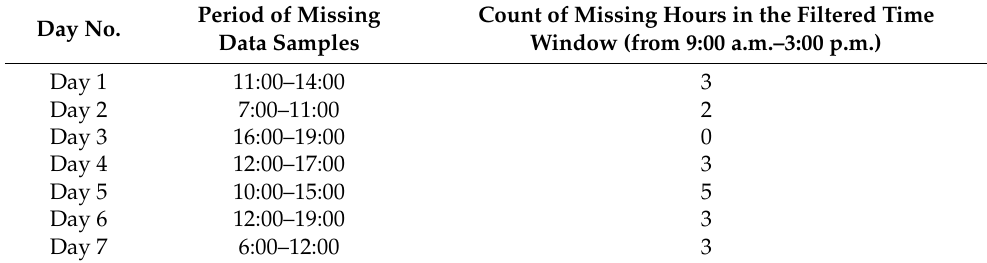
Table 5. Day number vs. count of missing